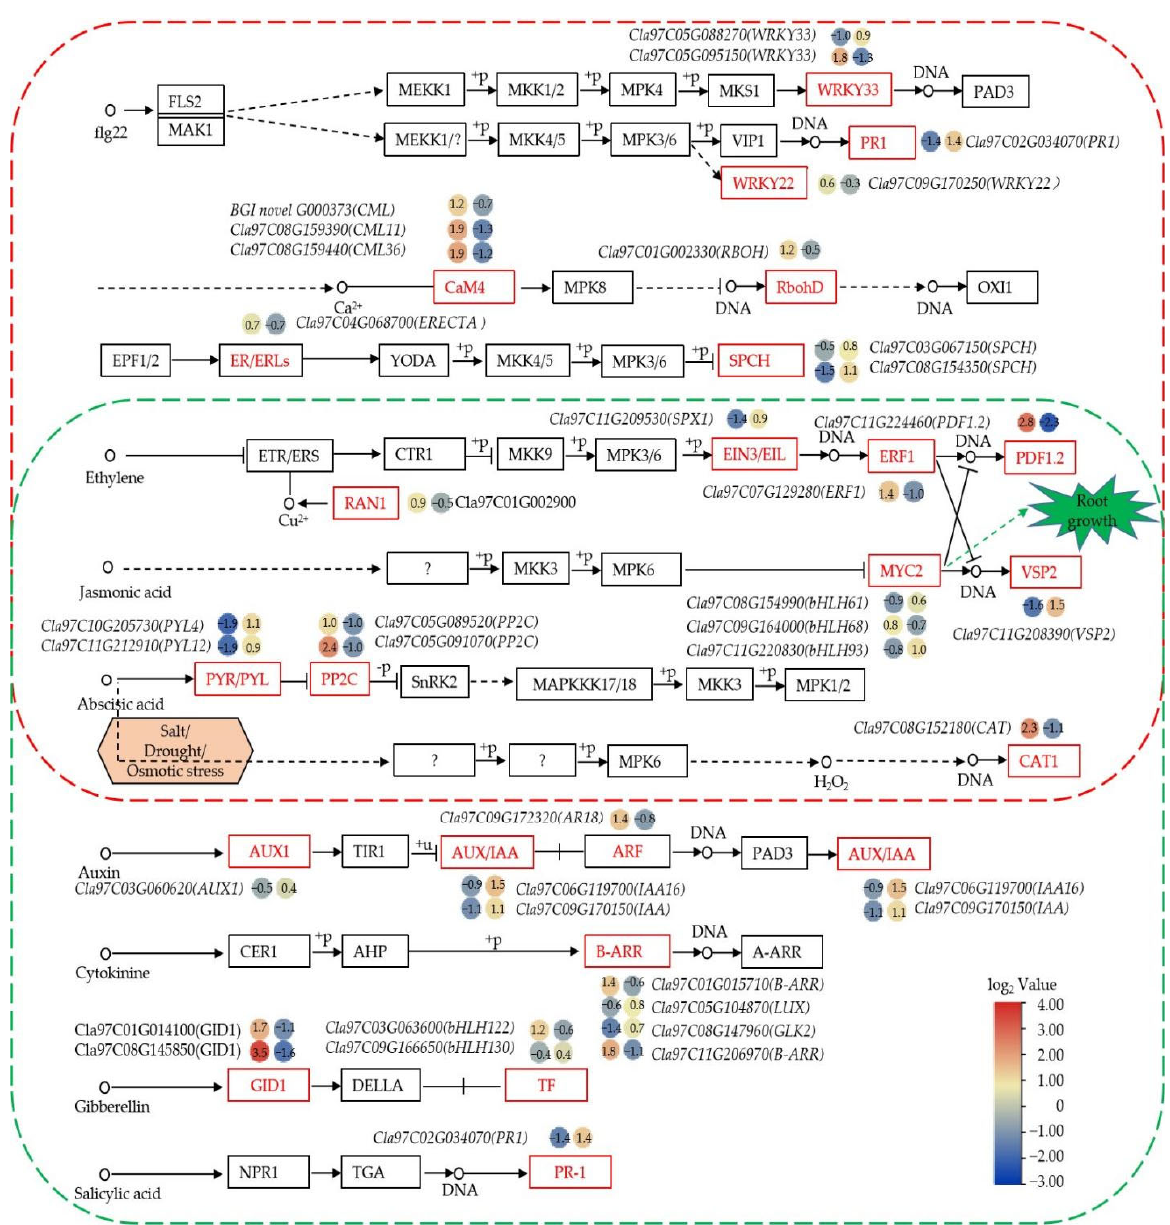
Figure 6. Analysis of MAPK signaling pathway—plant and plant hormone signal transduction in terms of DEGs. Red dotted box represents analysis of MAPK signaling pathway in terms of DEGs. Green dotted box represents analysis of plant hormone signal transduction in terms of DEGs. Genes in red line frame represent DEGs. The dots on the left represent the CK2–CK1 comparison group, and those on the right represent the T–CK2 comparison group. The color scale ranges from − 3 to 4, with blue indicating down ‐ regulation and red indicating up ‐ regulation (see the color set scale). CK1 represents watermelon seedlings cultured in normal Hoagland solution; CK2 repre ‐ sents watermelon seedlings cultured in Hoagland solution containing 150 mM NaCl, and T repre ‐ sents watermelon seedlings cultured in Hoagland solution containing 150 mM NaCl and 20 mM trehalose.